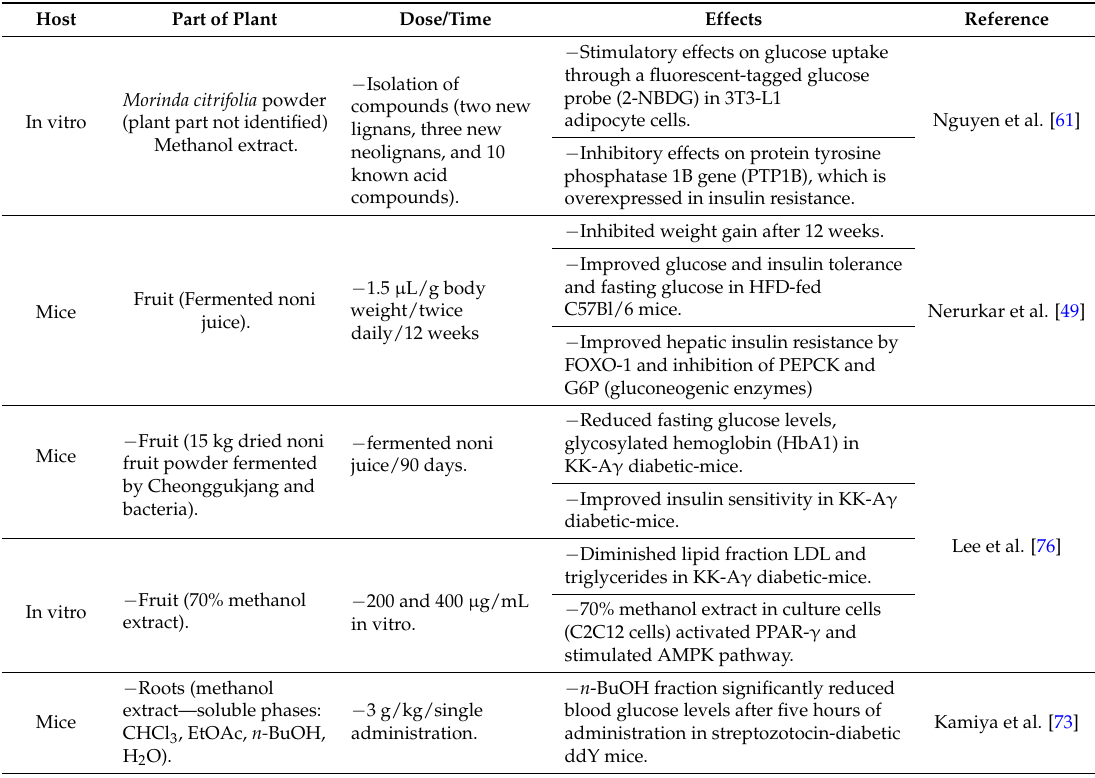
Table 3. The effects of administration of the Morinda citrifolia L. plant on insulin resistance/type 2 diabetes mellitus